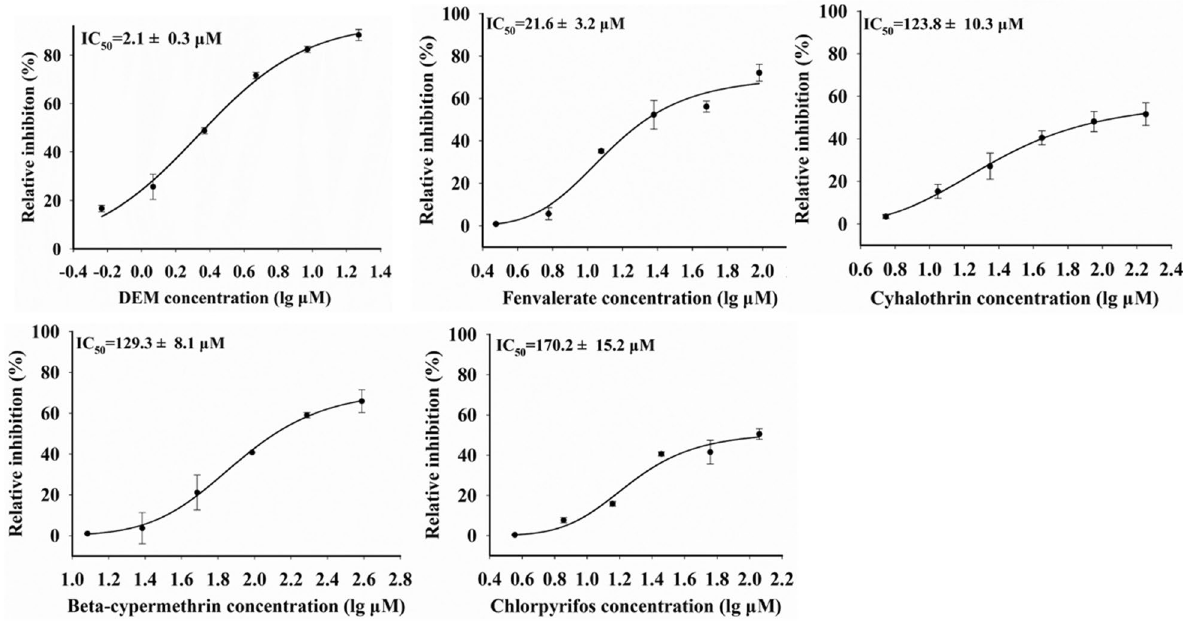
Figure 2. The IC 50 values of DEM, fenvalerate, cyhalothrin, beta-cypermethrin and chlorpyrifos on enzyme activity of SlGSTD1. Peak area of residual insecticides (mAu Treatment